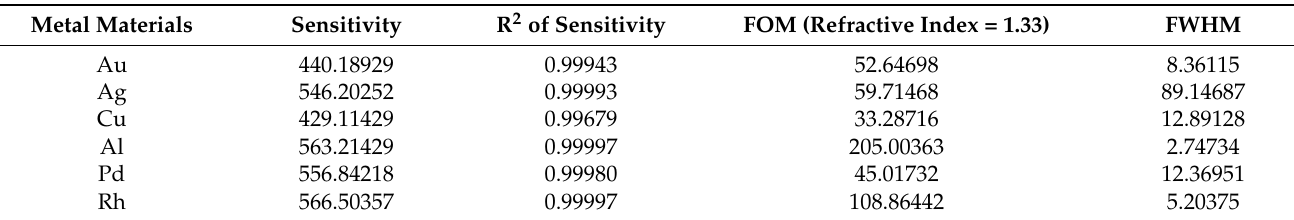
Table 2. Sensing performance and accuracy of different material of designed